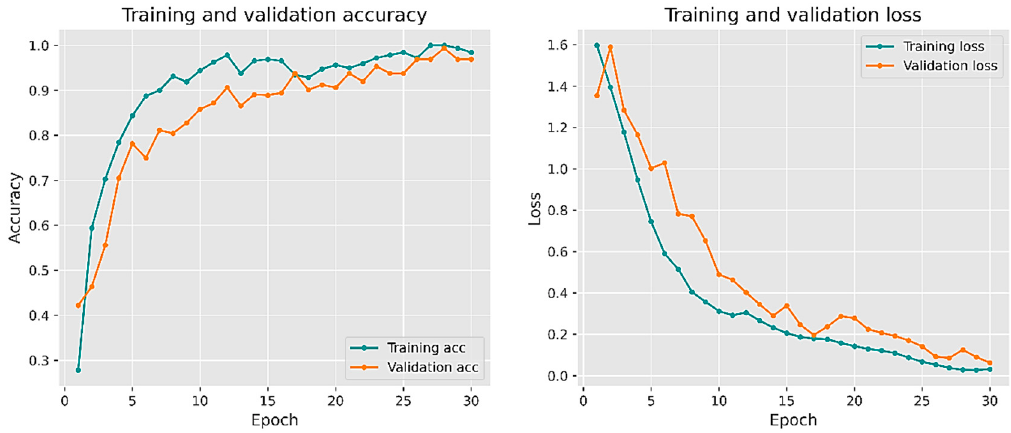
Figure 9. Performance of Model 9.